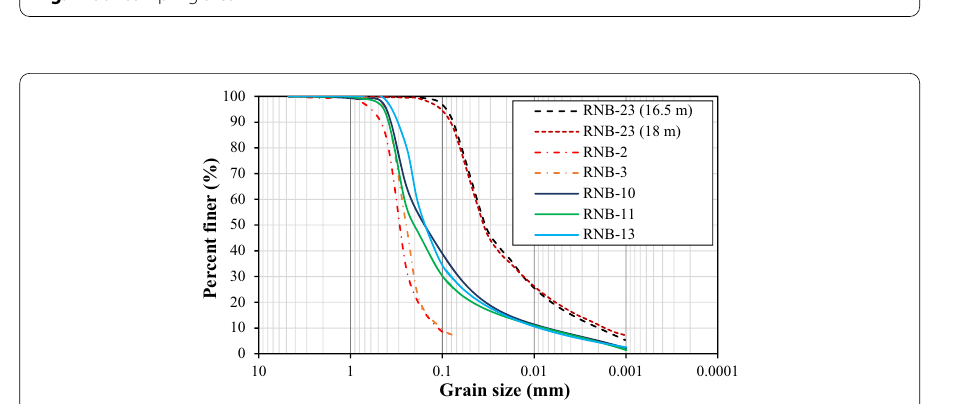
Fig. 3 The grain size distribution of soils